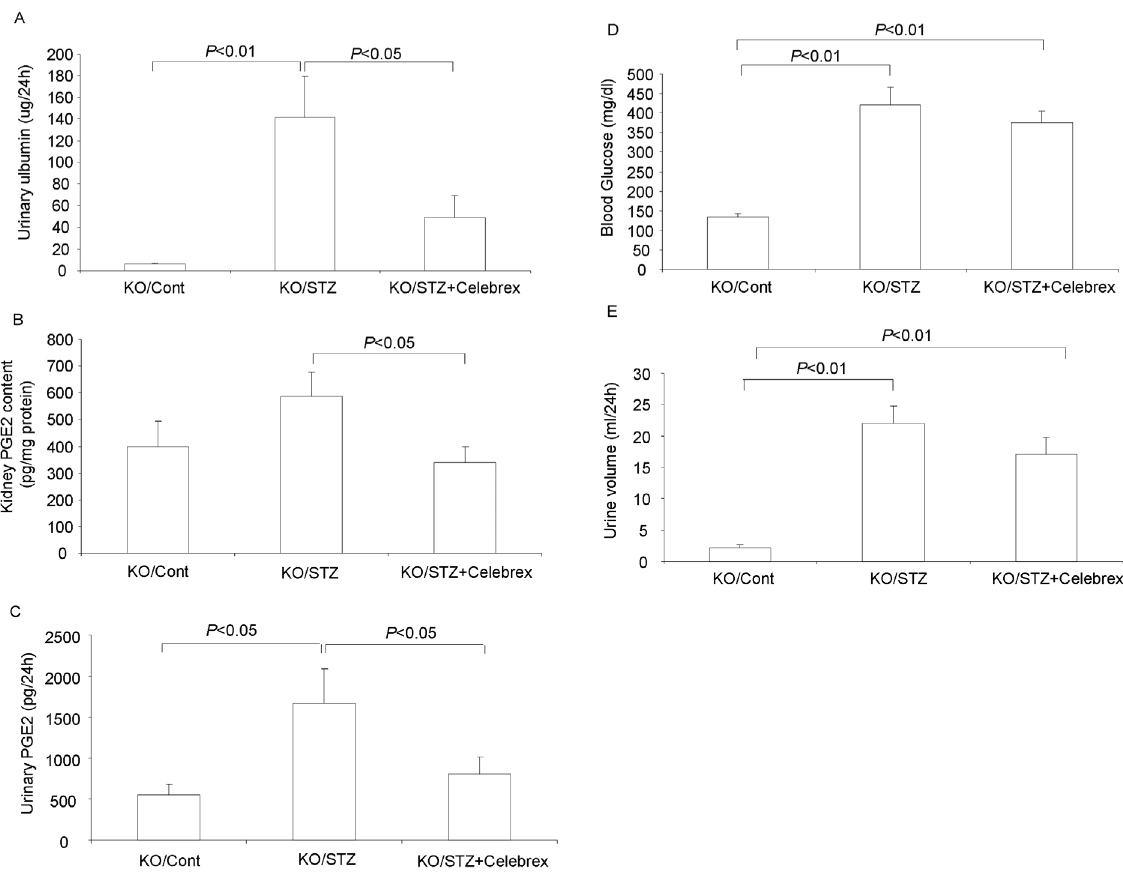
Figure 7. Effects of celebrex treatment on proteinuria and kidney PGE2 production in diabetic mPGES-1 KO mice. (A) Urinary ulbumin excretion (N=5–6 per group). (B) Kidney PGE2 content (N=5–6 per group). (C) Urinary PGE2 excretion. (D) Blood glucose levels (N=5–6 per group). (E) Urine volume. Data are mean 6 SE.